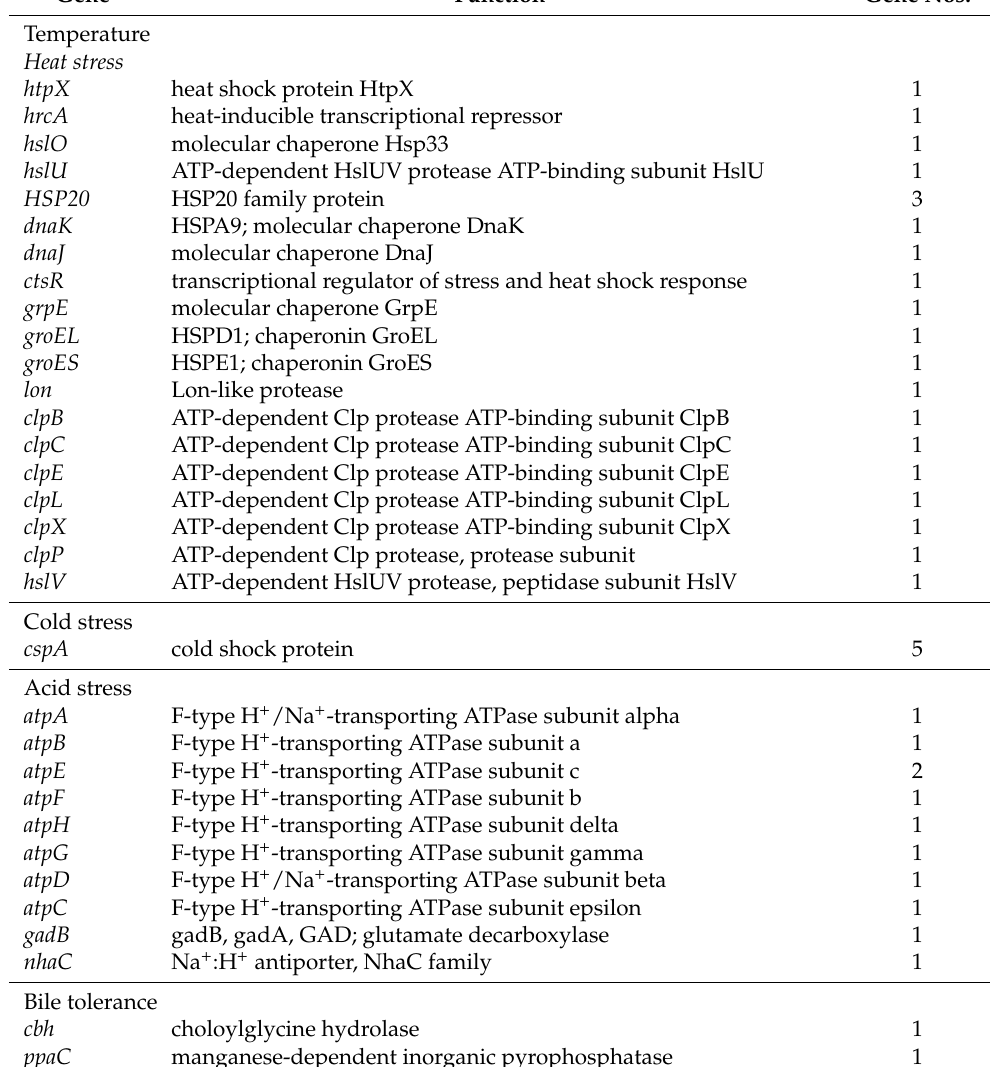
Table 4. List of probiotic marker genes identified in the Lactiplantibacillus plantarum DJF10 genome. Gene Function Gene